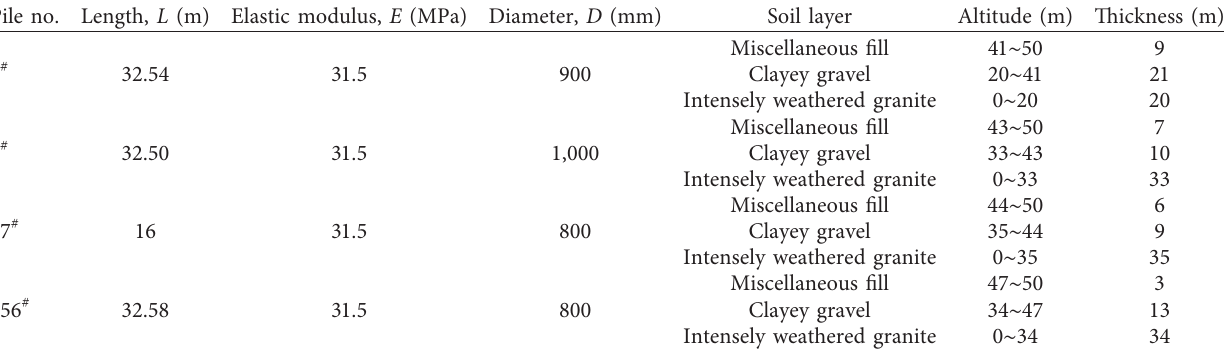
Table 2: Parameters of each pile foundation and soil layers.